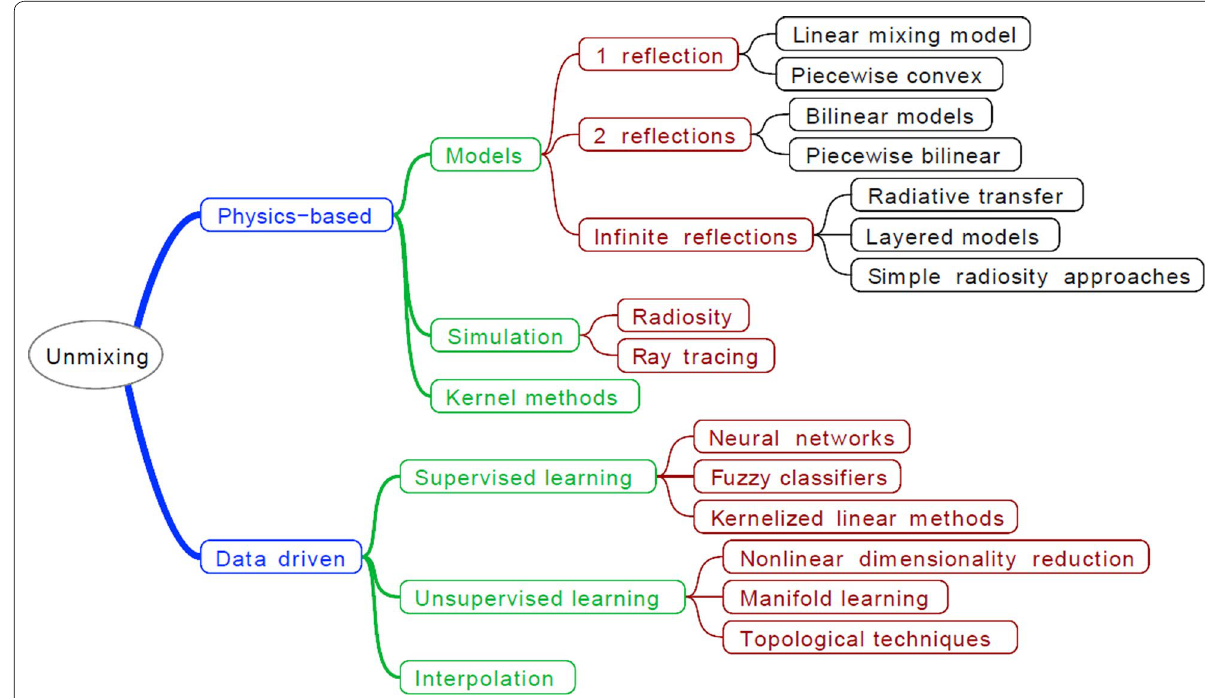
Fig. 1 Taxonomic tree of the different unmixing techniques presented in literature